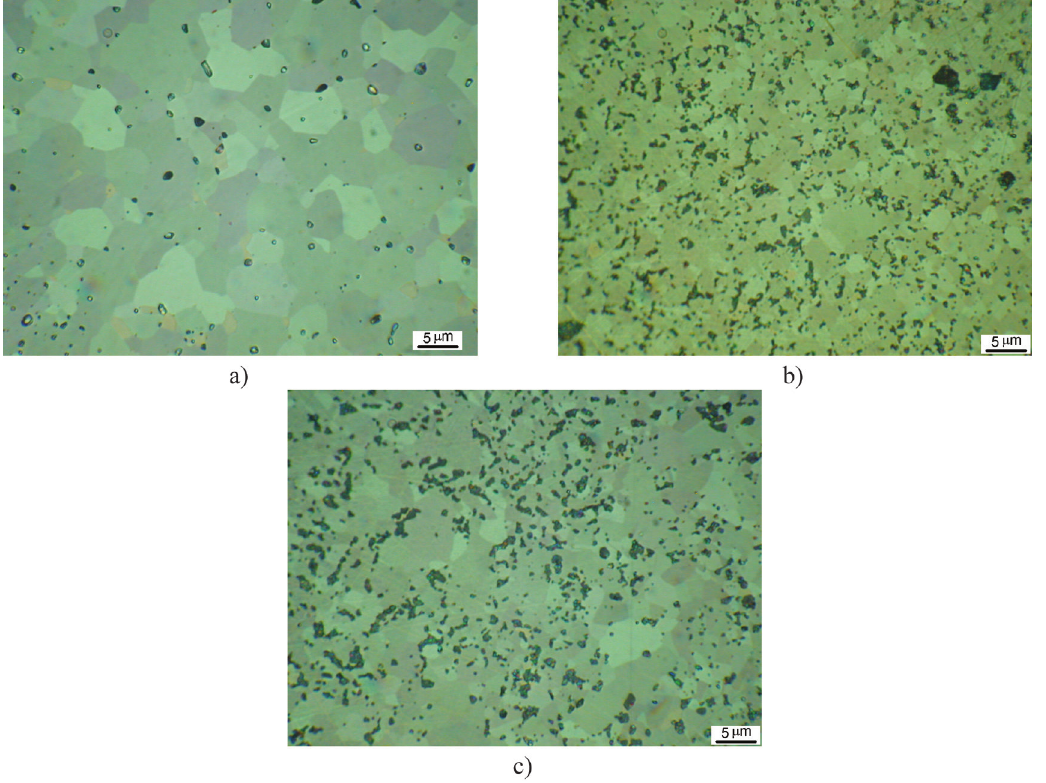
Fig. 1: Typical microstructure of the investigation materials: a) monolithic MoSi 2 , b) MoSi 2 + 10% nano SiC composite, c) MoSi 2 + 10% SiC